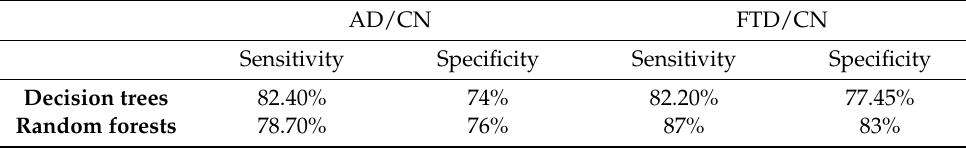
Table 4. Sensitivity and specificity results of decision trees and random forests